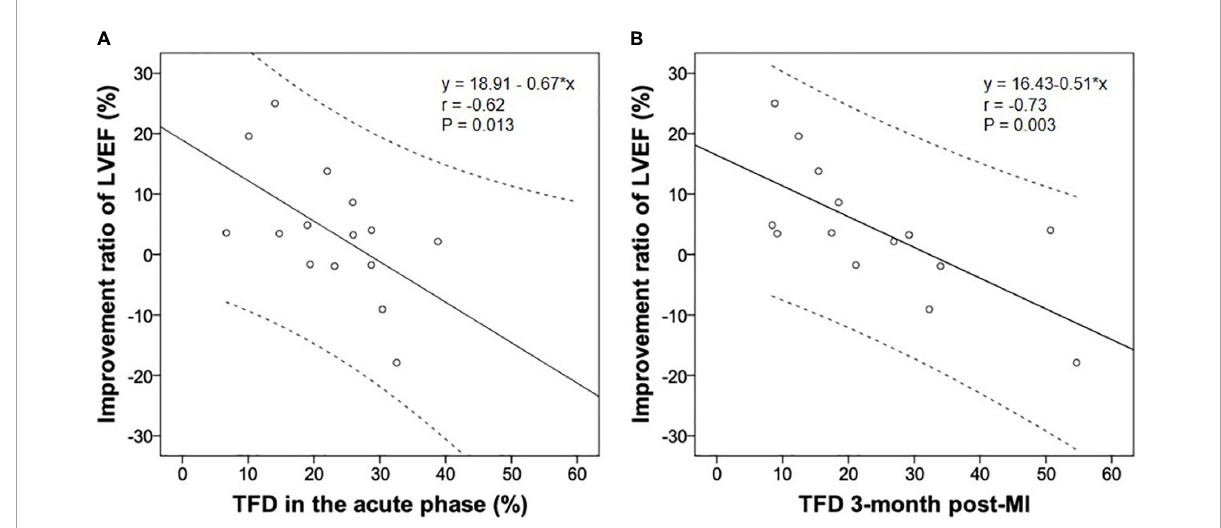
FIGURE2 The improvement ratio of LVEF post-infarction was inversely associated with the TFD in the acute (A) and convalescent phase (B) . LVEF, left ventricular ejection fraction; MI, myocardial infarction; TFD, total FDG uptake